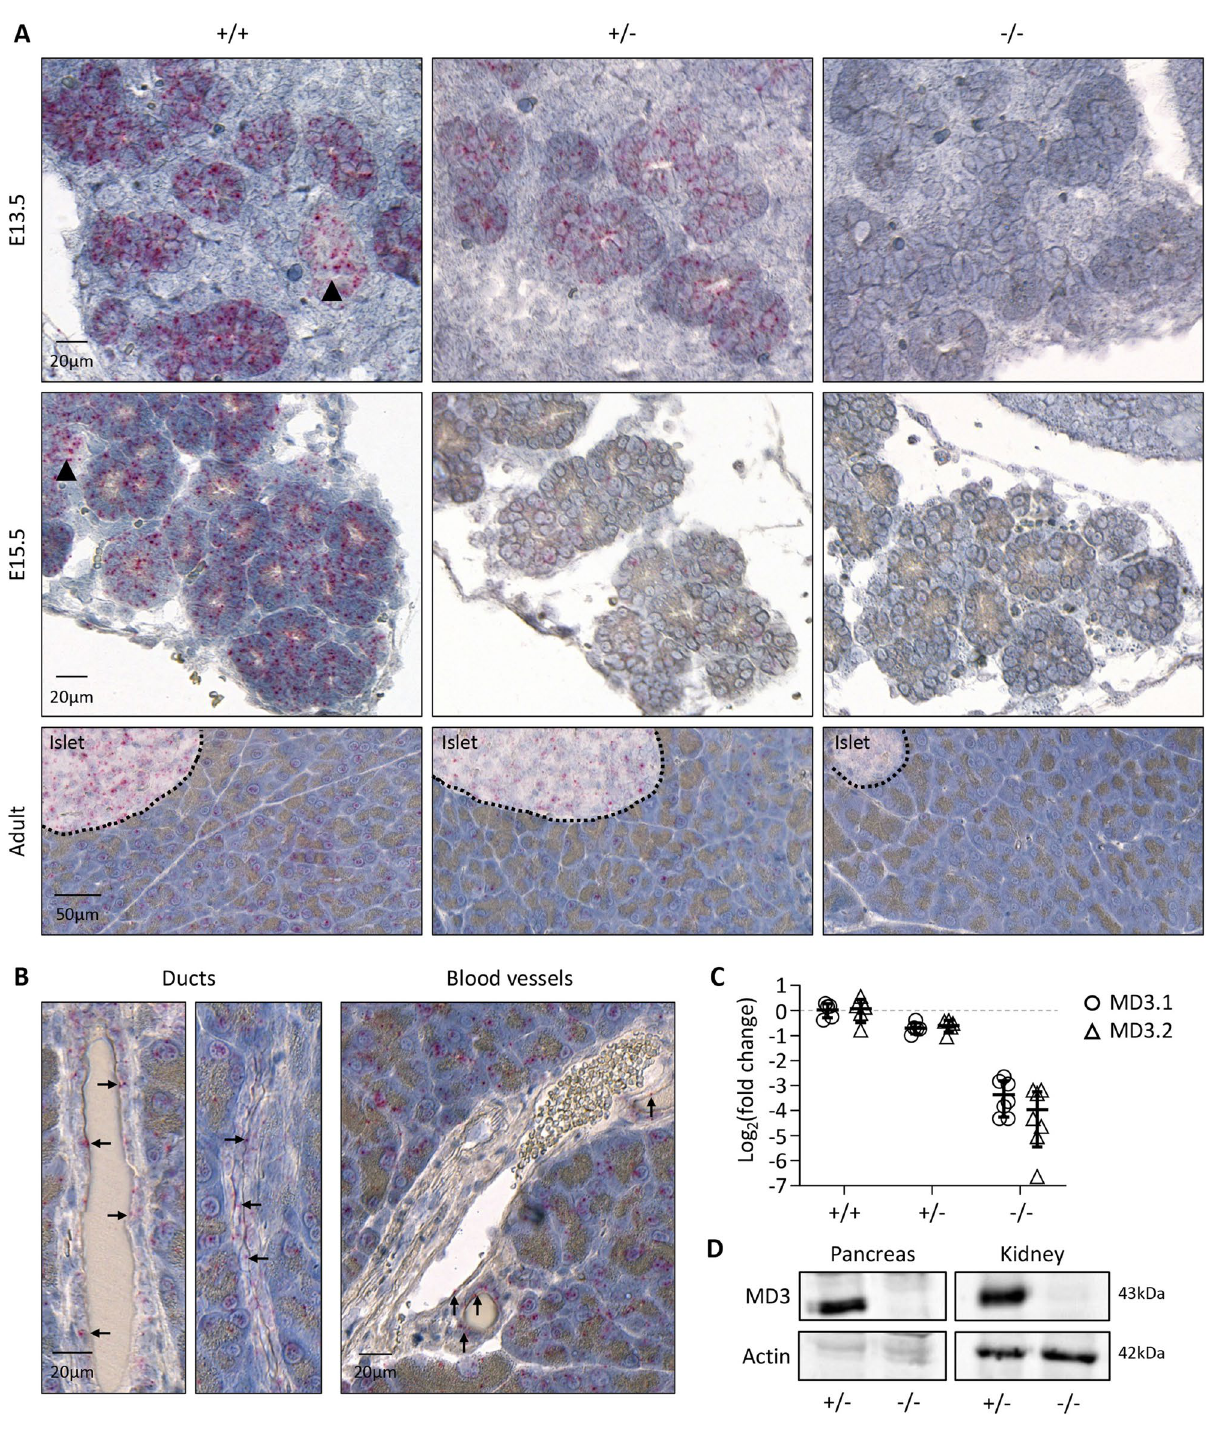
Figure 3. Validation of the MarvelD3 knockout mouse model. ( A ) Detection of MarvelD3 mRNA by RNAScope in situ hybridization on embryonic (E13.5 and E15.5) and adult pancreata from wild-type (+ / +), heterozygous (+ /−) and knockout (−/−) mice. Fast red chromogenic signals (pink dots) obtained with the MarvelD3 probe in wild-type tissues illustrate normal MarvelD3 mRNA expression. Deletion of one allele generates intermediate signal intensity, while deletion of the two MarvelD3 alleles abolishes pink staining. ( B ) High magnification images of MarvelD3 mRNA by RNAScope in situ hybridization in wild-type adult pancreas. MarvelD3 mRNA (pink dots) is found in the flattened intercalated and cuboidal intralobular pancreatic ductal cells (arrows), and in endothelial cells (arrows) of blood vessels of different sizes, located within the pancreatic parenchyma. ( C ) Relative expression levels of MarvelD3 isoforms ( MD3.1 , open circle; MD3.2 , open triangle) measured by RT-qPCR in E15.5 pancreata of + / + , + /− and −/− embryos. An approximate 50% and 90% decrease in MarvelD3 expression was observed in + /− and −/− mice, respectively, as compared to wild-type (+ / +) mice. β-actin was used as internal PCR control (ΔCt) and the values were then compared to the expression of MD3.1 or MD3.2 in the + / + (ΔΔCt). Data are represented in Log 2 fold changes. ( D ) Western blotting of MarvelD3 (MD3) and β-actin (Actin) in pancreatic and renal protein lysates of heterozygous (+ /−) and knockout (−/−) mice. MarvelD3 can be detected in heterozygous pancreas and kidney, while it is absent in knockout tissues. Actin levels vary between tissues, but are constant in the different samples of the same tissue. Full-length blots/gels are presented in Supplementary Fig.